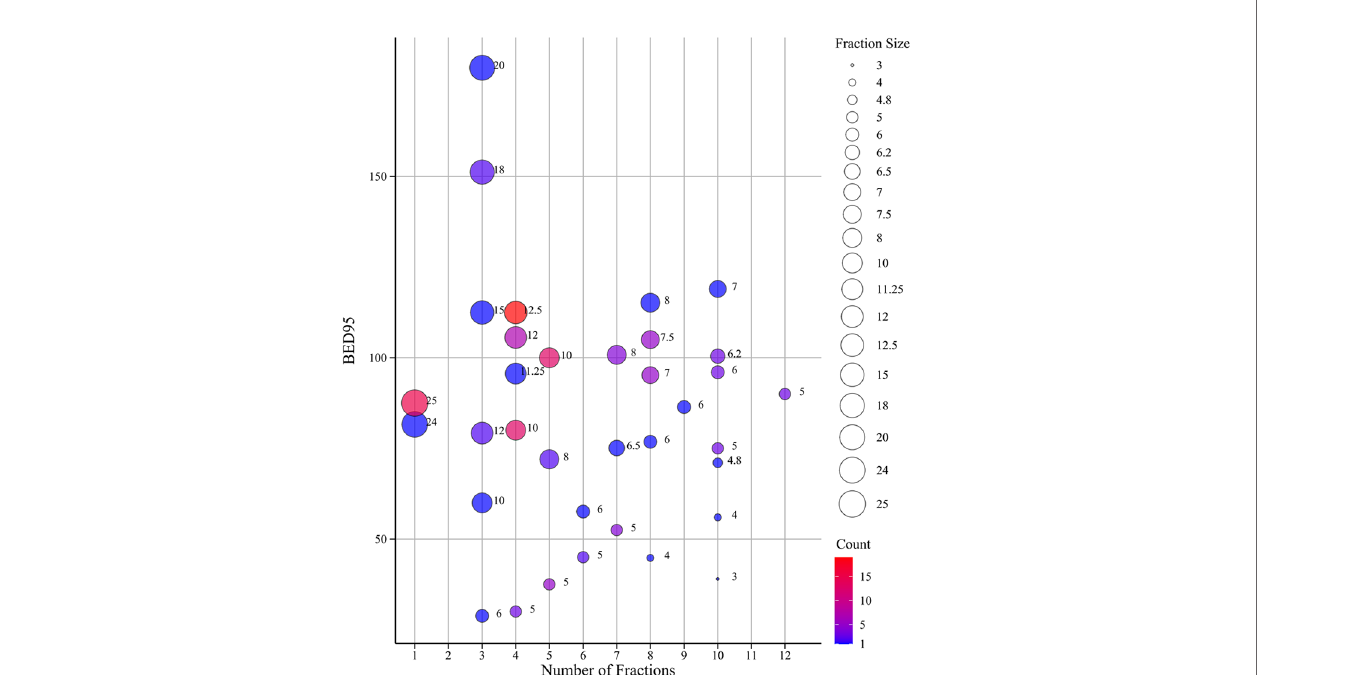
FIGURE 2 | The bubble chart of fractionation schemes and BED 95 . The size of dots indicates the size of fraction; the different color of dots indicates different count ranges. BED 95 , the prescription dose covers 95% of the target area expressed as BED.